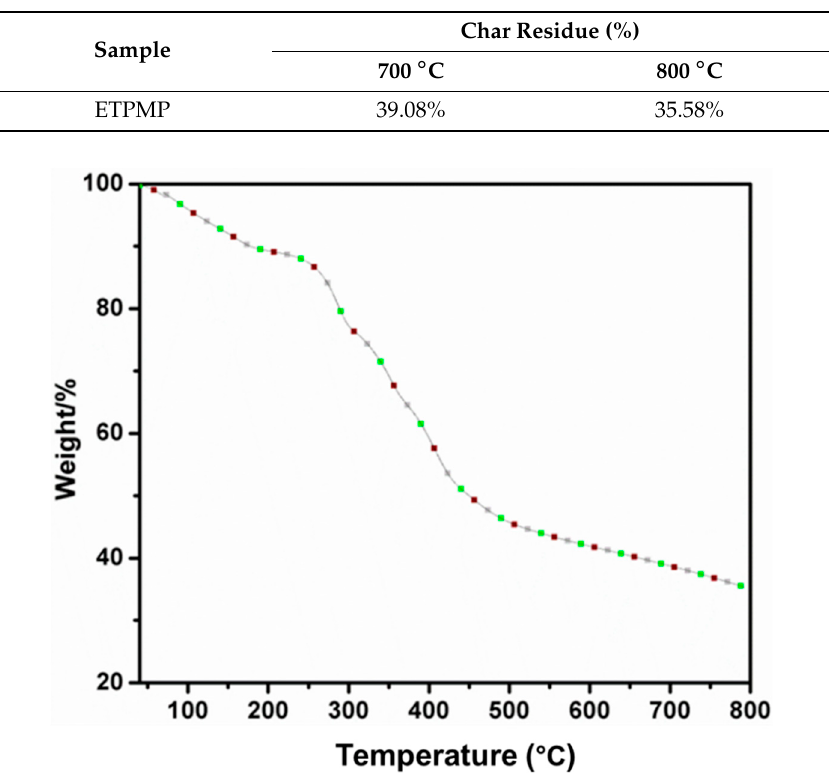
Figure 2. TGA curve of ETPMP.